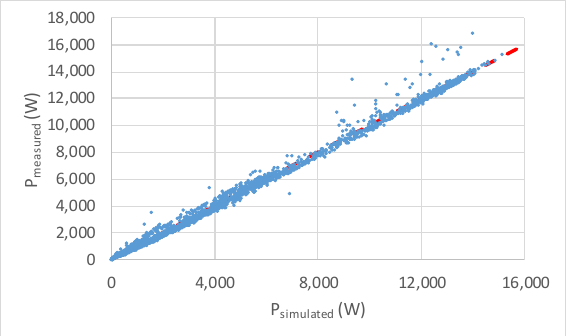
Figure 5. Measured vs. simulated photovoltaics (PV) system output power (red line is to guide your eyes).